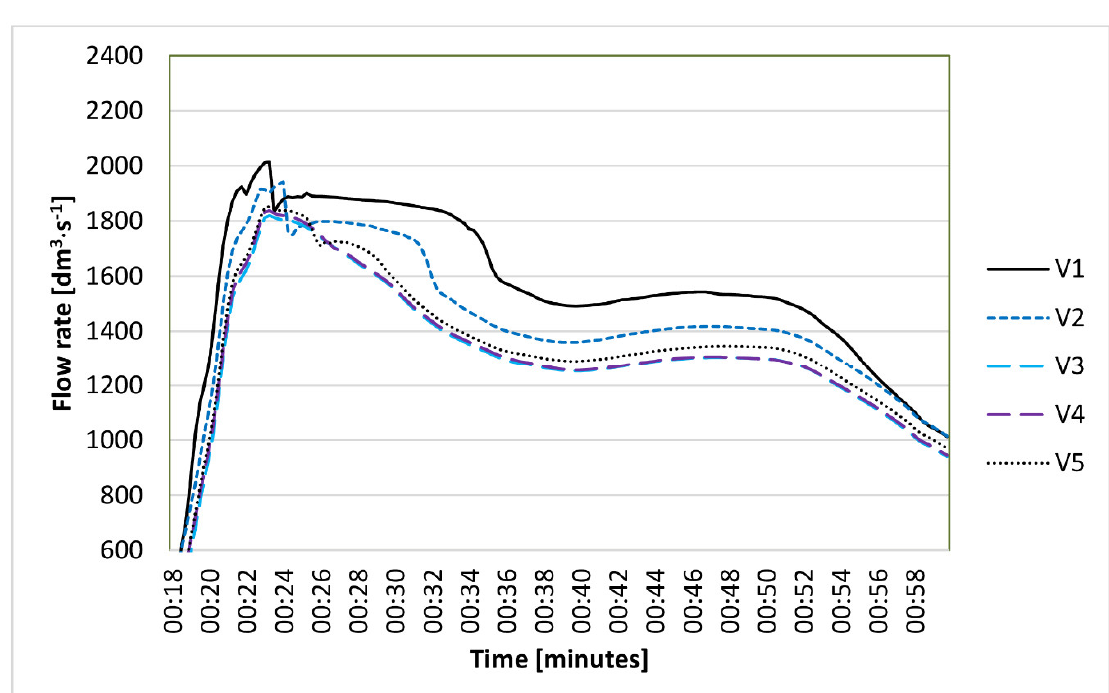
Figure 11. Change in flow rate in Link-30—F = 3 years.